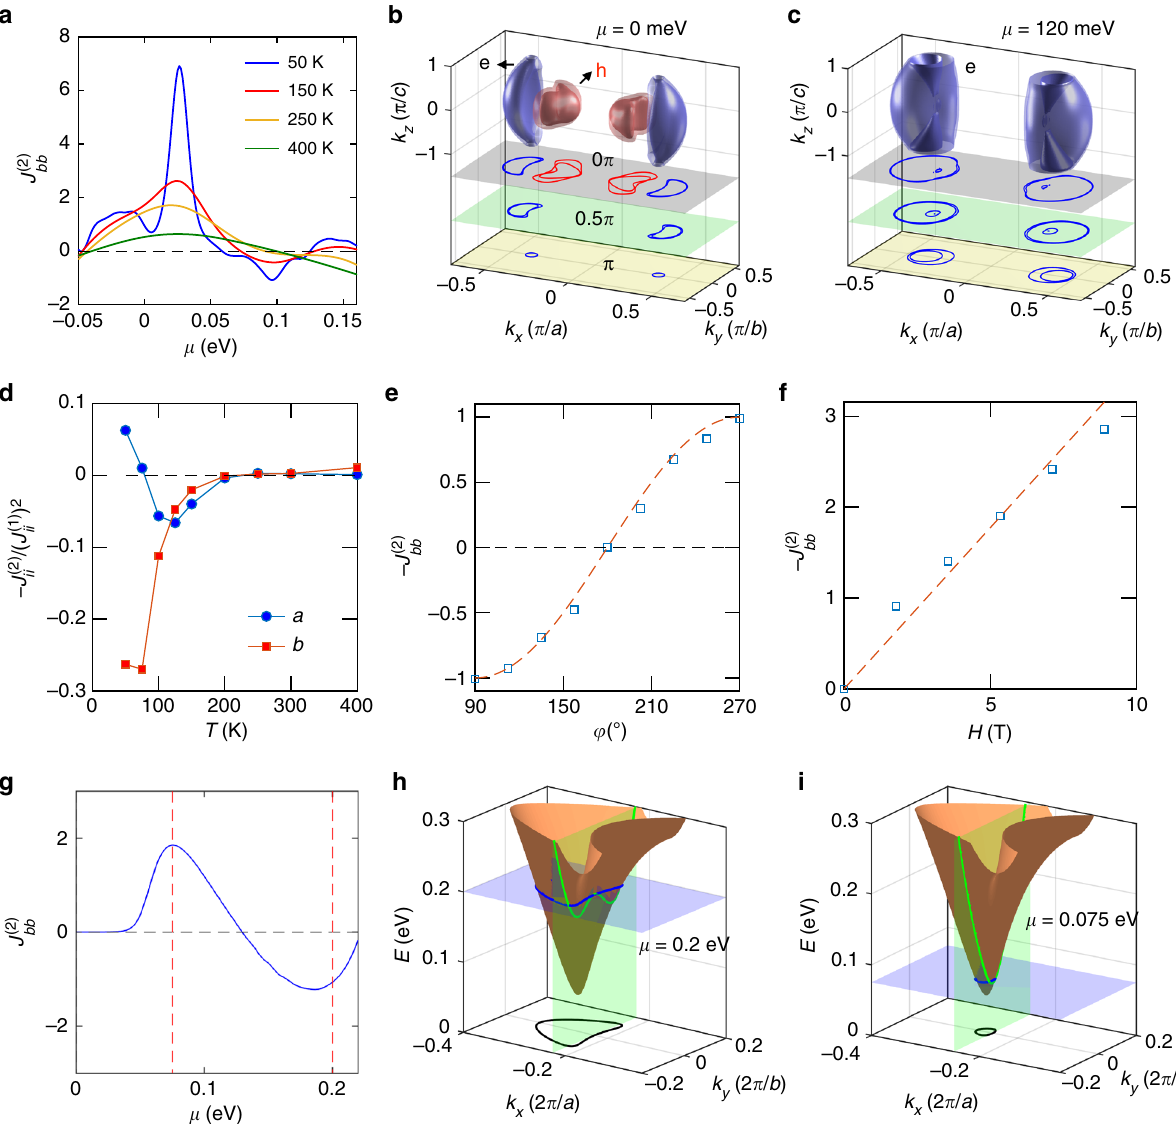
Fig. 4 Theoretical nonlinear charge current and Fermi surface. a Calculated longitudinal second-order current density J ð 2 Þ bb versus Fermi level µ for current fl owing along the b axis with a Zeeman energy of 0.1 meV. b , c Calculated Fermi surfaces of bulk WTe horizontal cuts shown underneath. ‘ e ’ and ‘ h ’ indicates the electron and hole pocket, respectively. Based on the result of Fig. 2f, these two chemical potentials correspond to T = 0 K and 300 K, respectively. d Temperature dependence of the ratio (cid:2) J ð 2 Þ ii = J ð 1 Þ ii axes. The T axis takes into account both the thermal broadening by the Fermi-Dirac distribution and the Fermi level shift. e , f Variation of the calculated J ð 2 Þ bb at 300 K with magnetic fi eld angle φ ( e ) and with the fi eld intensity at φ = 90° ( f ). Dashed lines are, respectively, the function sin( φ ) and a linear fi t to the calculated points. The above results in a – f are calculated based on the Wannier Hamiltonian of bulk WTe 2 , which reproduces the density functional theory (DFT) band structure shown in Fig. 1b. g The calculated second-order current density J ð 2 Þ bb versus the Fermi level µ for the simpli fi ed quasi-bulk tight-binding model. h , i The energy dispersion and Fermi surfaces at µ = 200 and 75 meV, respectively, which correspond to the values marked by the vertical dashed lines in g . Calculated currents are presented in arbitrary units in all panels (Supplementary Note